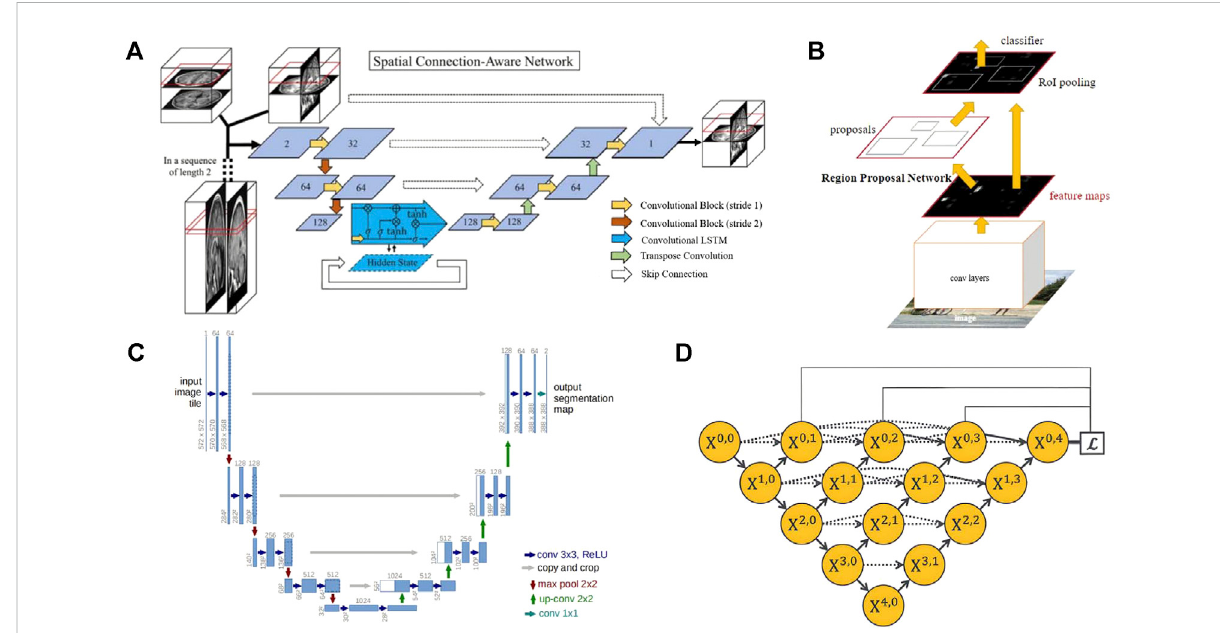
FIGURE 8 Some network frameworks applied in MRI image processing and analysis. (A) Spatial connectivity-aware network including LSTM blocks, exploiting sagittal information from adjacent slices. (adapted and modi fi ed from Li et al., 2019). (B) The Faster R-CNN network structure has two branches,theboundingboxregressionnetworkandtheclassi fi cationnetwork.Theregionproposalnetworkisusedtorecommendboundingboxes thatmayhavetargets.(adaptedandmodi fi edfromRenetal.,2015). (C) U-netisoftenusedasabasicnetwork.Theblueboxesrepresentfeature maps with different number of channels, the white boxes represent the copied feature maps, and the arrows represent operations such as convolution, pooling, etc. (adapted and modi fi ed from Ronneberger et al., 2015). (D) The UNet++ network obtained by improving U-Net, the downward arrow indicates downsampling, the upward arrow indicates down adoption, and the dot arrow indicates skip connections between feature maps. (adapted and modi fi ed from Zhou et al.,